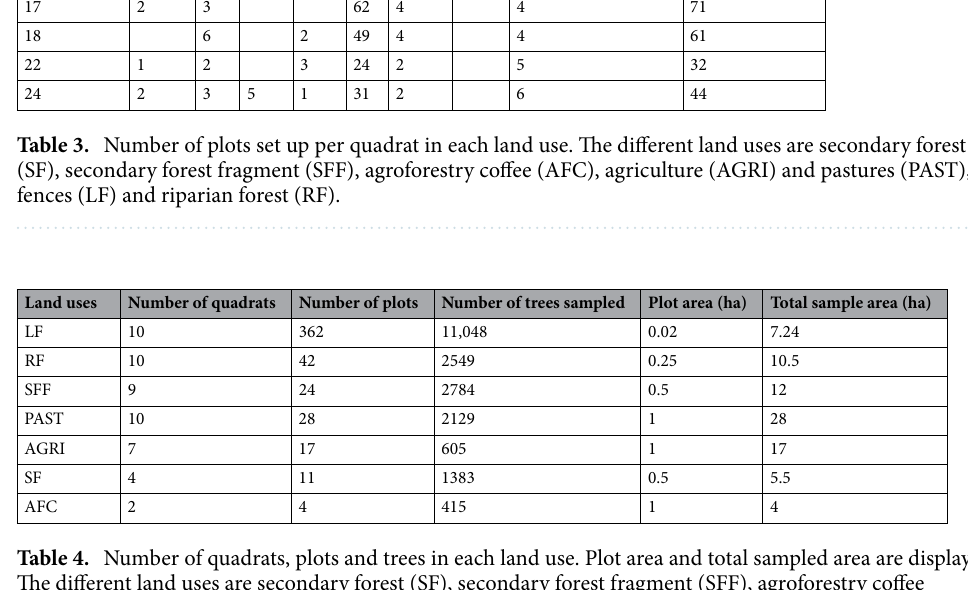
Table 4. Number of quadrats, plots and trees in each land use. Plot area and total sampled area are displayed. The different land uses are secondary forest (SF), secondary forest fragment (SFF), agroforestry coffee plantations (AFC), agriculture (AGRI) and pastures (PAST), live fences (LF) and riparian forest (RF).